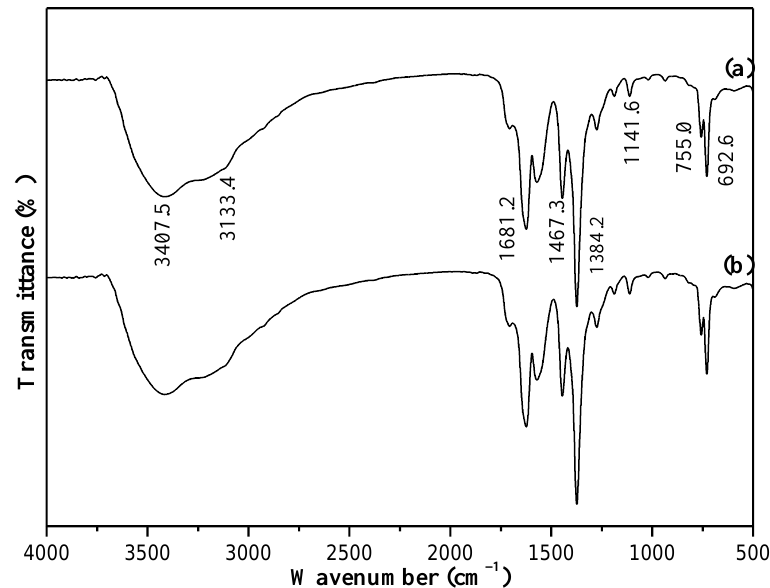
Figure 1. FT-IR spectrum of Co-ZIF catalyst. ( a ). fresh, ( b ). after reaction.